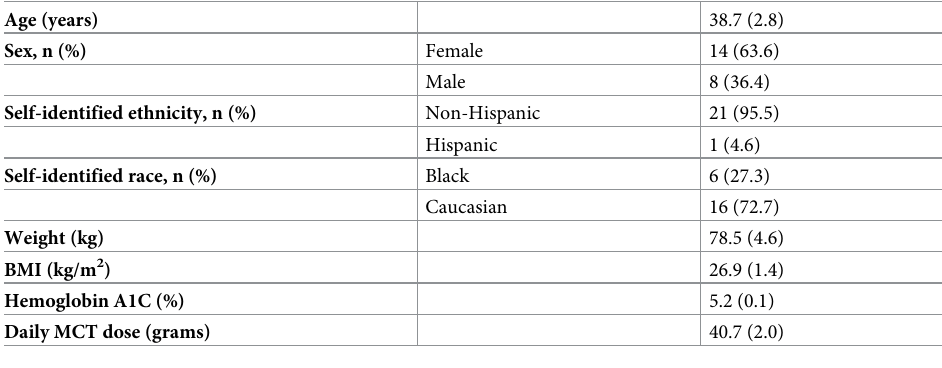
Table 1. Baseline demographic and metabolic parameters of study participants (n =